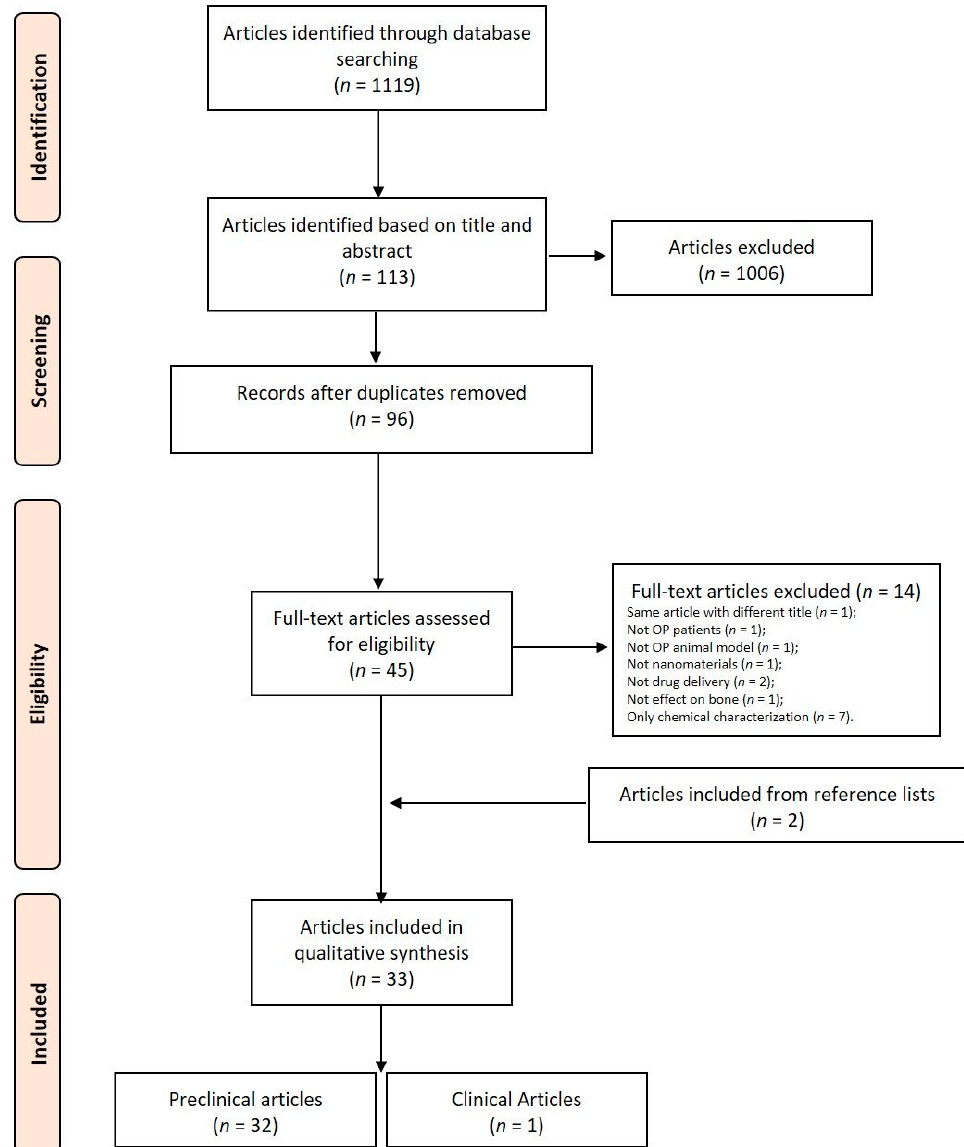
Figure 2. Preferred Reporting Items for Systematic Reviews and Meta-Analyses (PRISMA) flowchart for the selection of studies.